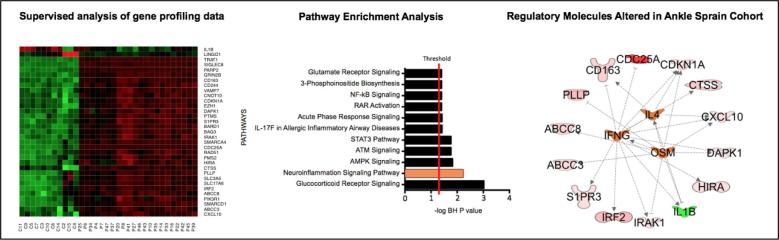
Genetic profiling analysis. (A) Heat map of 33 differentially expressed genes from saliva of injury patients vs. control subjects. Supervised analysis of gene profiling data from ankle injury patients and control subjects. The genes with multiple test corrected p value <0.05 and absolute change >2 folds were considered significantly and differentially expressed. In each heat map, rows depict differentially expressed genes and columns depict individual subjects. The relative expression level of genes is shown using a pseudocolor scale from −3 to +3 (green represents down regulation and red represents up regulation). (B) Pathways enrichment analysis of genes that are differentially expressed in saliva from ankle injury patients compared to controls. This analysis depicts the significant effect on multiple stress and inflammation pathways including DNA Damage, Neuroinflammation, AMPK and ATM signaling. Pathways with multiple test corrected p value <0.05 were considered significant. (C) Top regulatory molecules (orange) significantly altered in injury group as compared to controls. Lines ending in an arrow represent amplification and those ending in a flat line represent an inhibitory connection. (For interpretation of the references to color in this figure legend, the reader is referred to the web version of this article.)